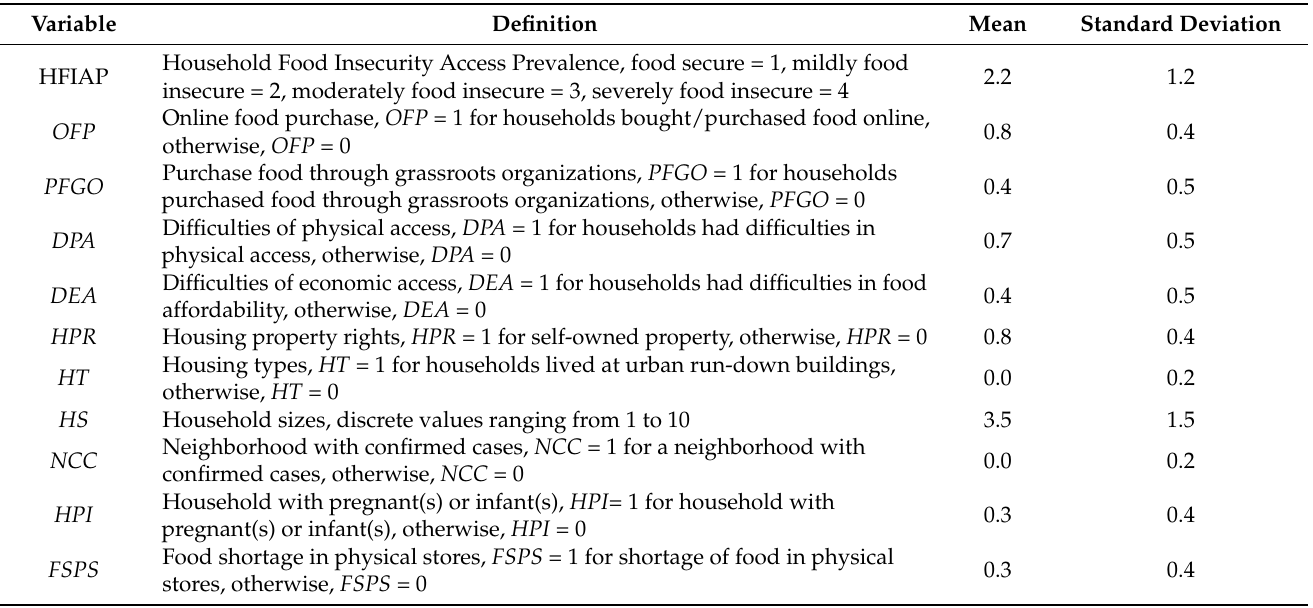
Table 1. Dependent and independent